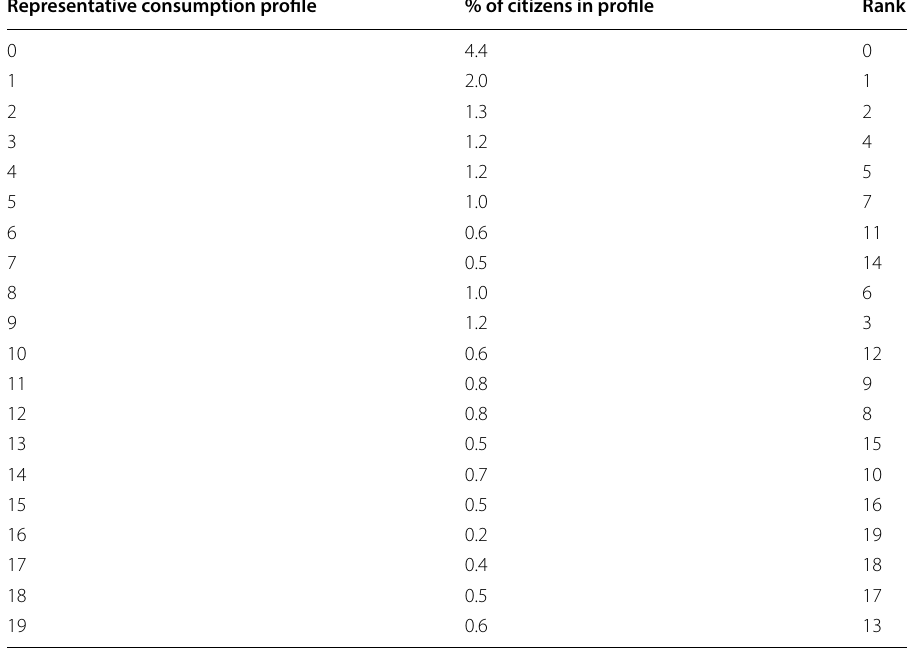
Table 1 Ranked city consumption